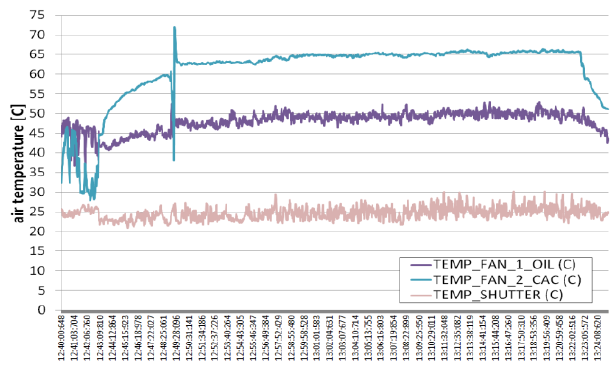
Fig. 3. Engine operating parameters during the measurement – engine Fig. 7. Temperature of cooling air measured on the exchangers cover and speed (black), engine load (green), engine torque (red), coolant tempera- on the fan cover ture (blue)